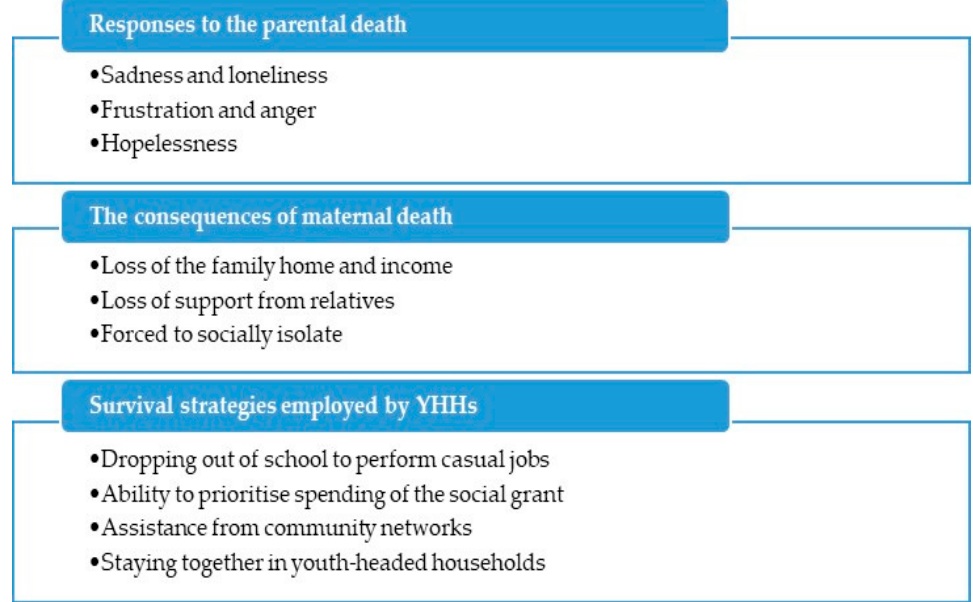
Figure 1. Emergent themes and subthemes.